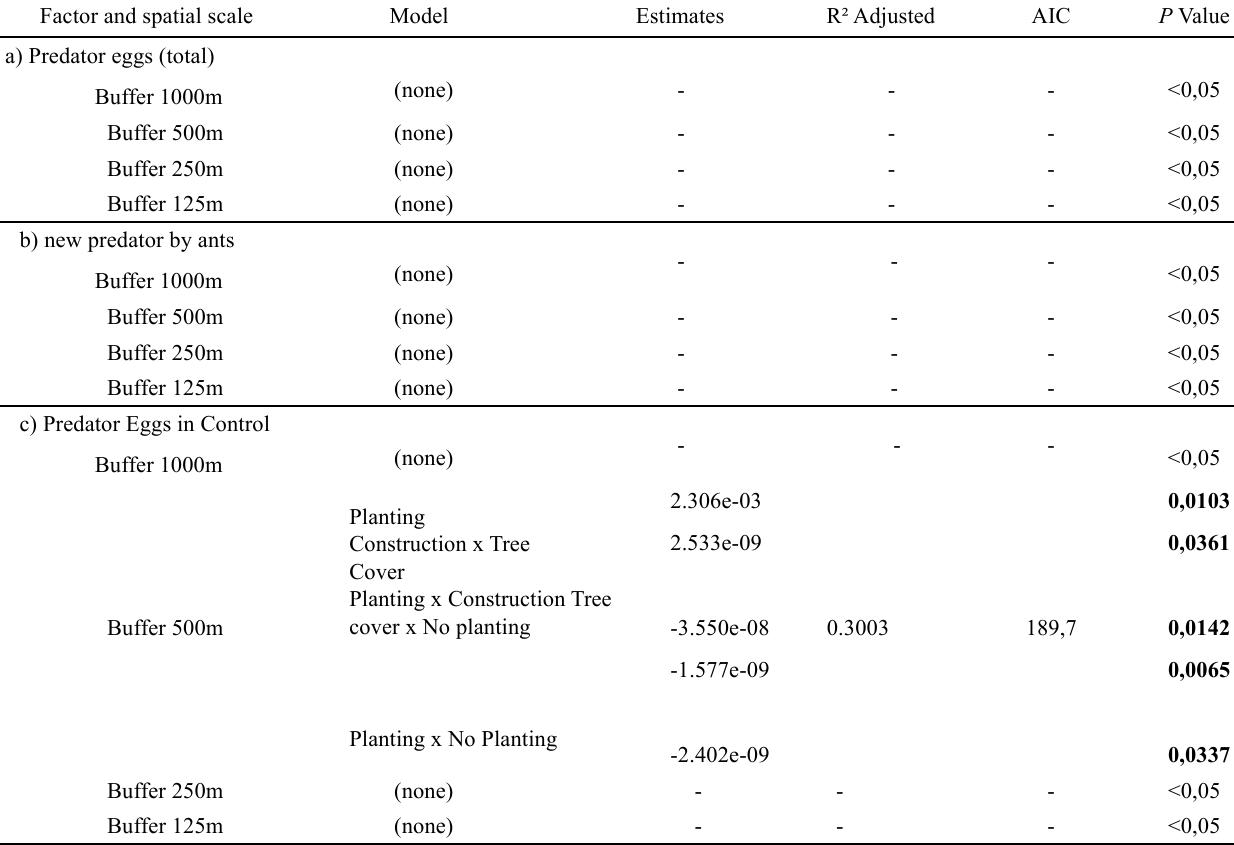
Table 2. Linear model that explains the influence of landscape on predation rates on Belenois solilucis eggs. The experiment was carried out in 18 localities of production of organic vegetables in the Rashad, Sudan, Sudan, from February to June 2020 and February to May 2021. Factor and spatial scale